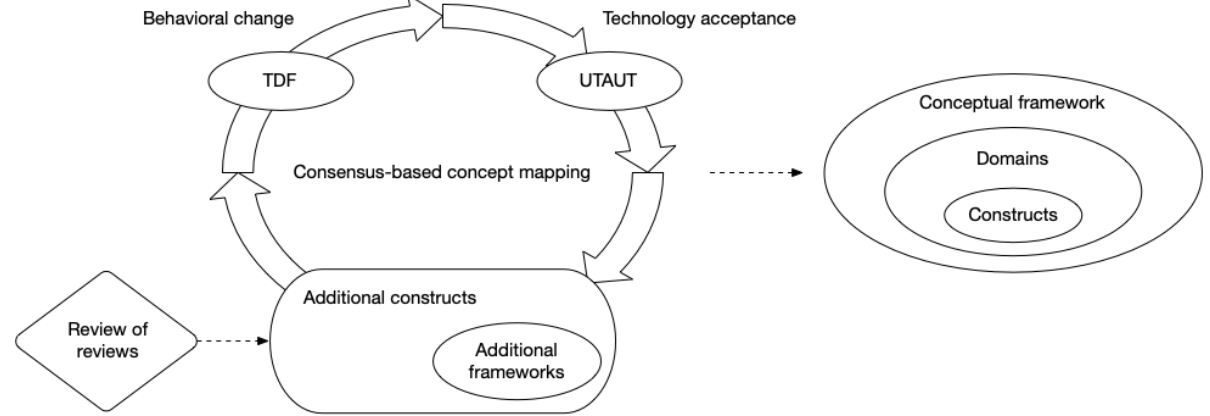
Figure 1. Framework development. TDF: Theoretical Domains Framework; UTAUT: Unified Theory of Acceptance and Use of Technology.